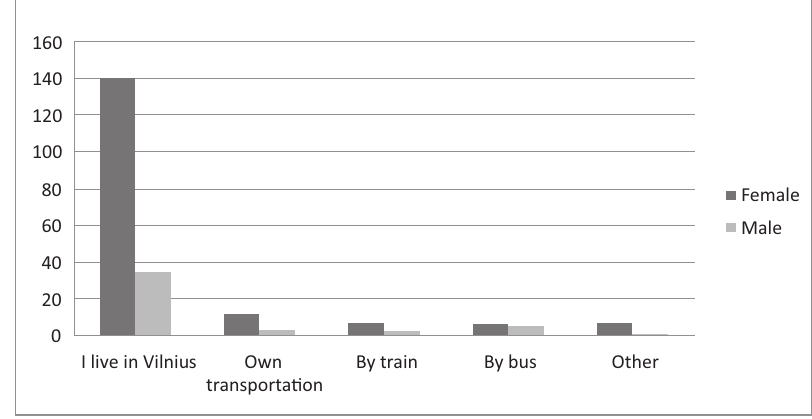
Fig. 13. Correlation between transportation type visitors have arrived to the festival and gender